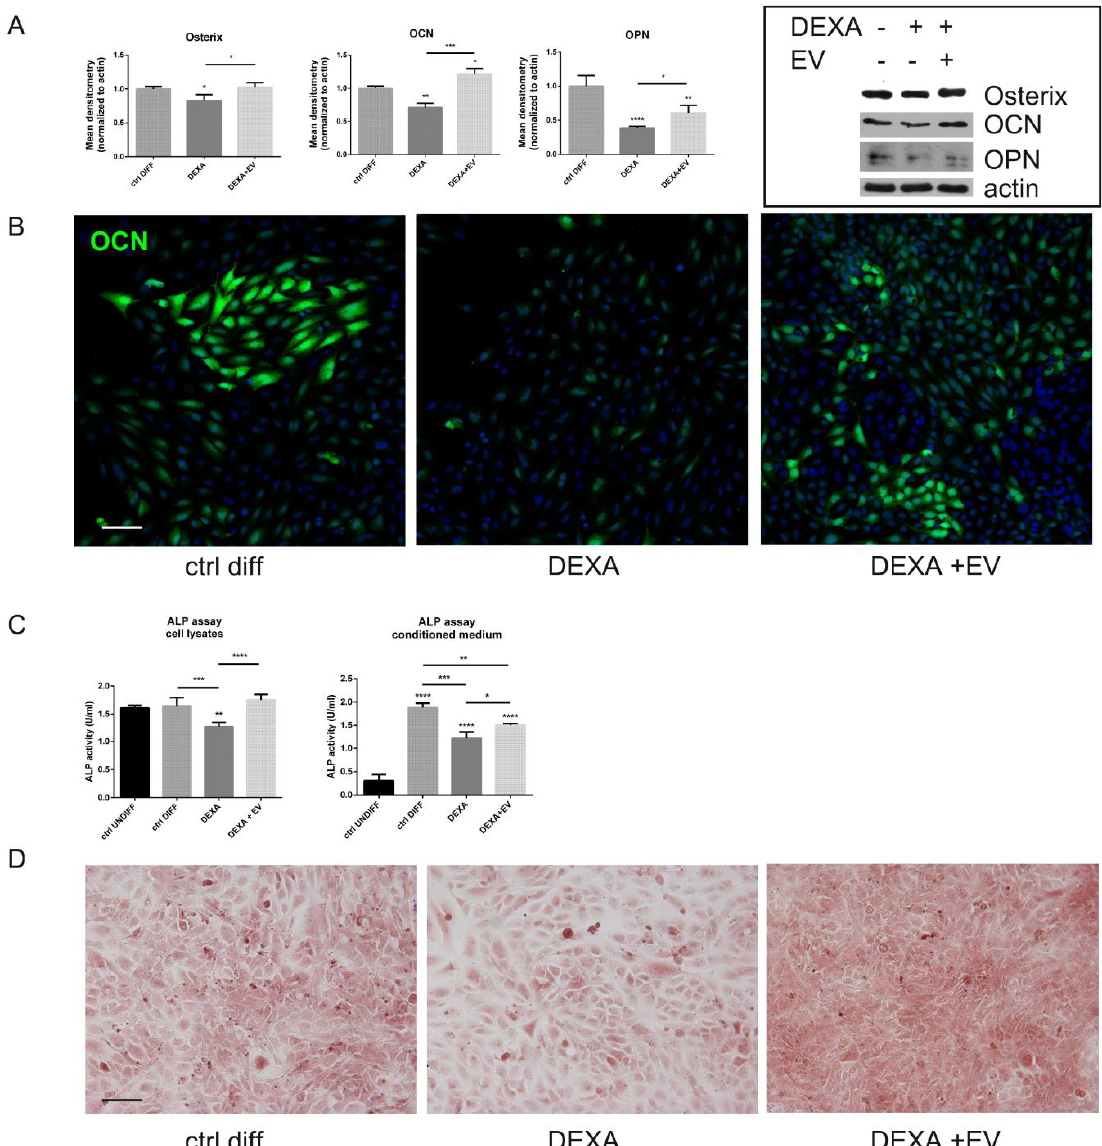
Figure 4. Effect of AFSC-EV supplementation on osteogenic differentiation markers of HOB treated or not with Dexamethasone. ( A )—Western blot analysis of total lysate of differentiated HOB cells treated or not with AFSC-EV and DEXA, then revealed with the indicated antibodies. The graphs represent the mean ± SD of densitometric analysis of three experiments, normalized to actin values. * p value < 0.05; ** p value < 0.01; *** p value < 0.001; **** p value < 0.0001. ( B )—Representative images showing DAPI (blue) and osteocalcin (OCN) (green) signals of HOB cells incubated or not with EV and DEXA. Scale bar= 30 µ m. ( C )—ALP assay performed on total lysate or on conditioned medium, as reported in M&M section, of HOB treated or not with AFSC-EV and DEXA. * p value < 0.05; ** p value < 0.01; *** p value < 0.001; **** p value < 0.0001. ( D )—Representative images of Alizarin Red staining of HOB cells incubated or not with AFSC-EV and DEXA are shown. Scale bar= 50 μm.